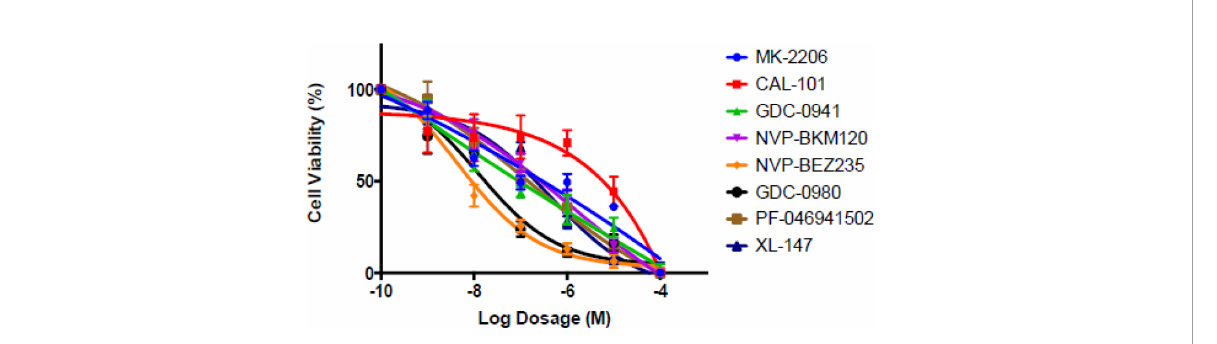
FIGURE 4 The thymoma cell line, IU-TAB-1 with increasing dosages of PI3K, AKT and dual PI3K/mTOR inhibitors. Cells were treated for 72 hours, and cell viability was assessed. The data demonstrates marked sensitivity of the cell lines to these inhibitors including Buparlisib (NVP